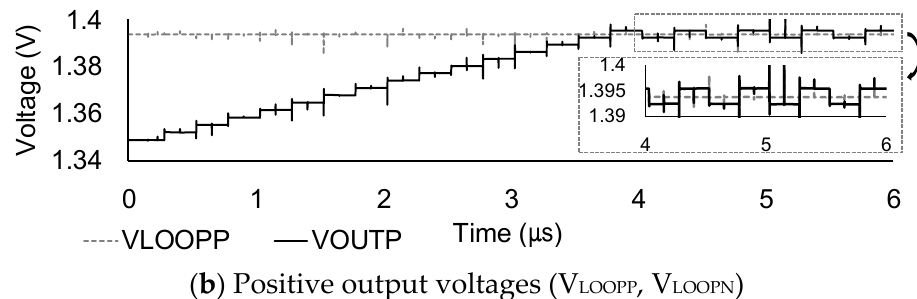
Figure 9. Simulated waveform of the proposed adaptive amplitude tuning at DC.